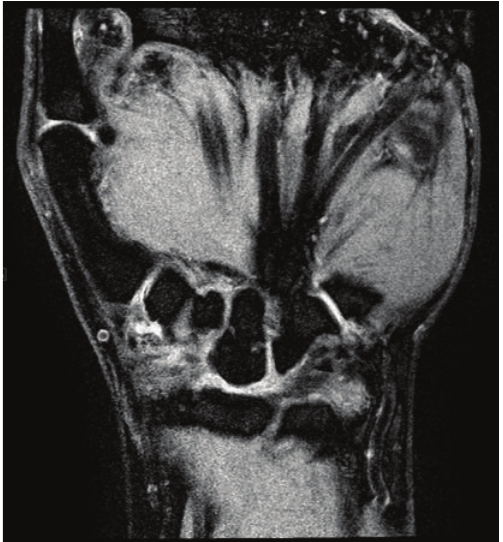
Figure 5: Post-op MRI: no significant chondropathy in fossa lunata or at proximal capitate and no bone marrow